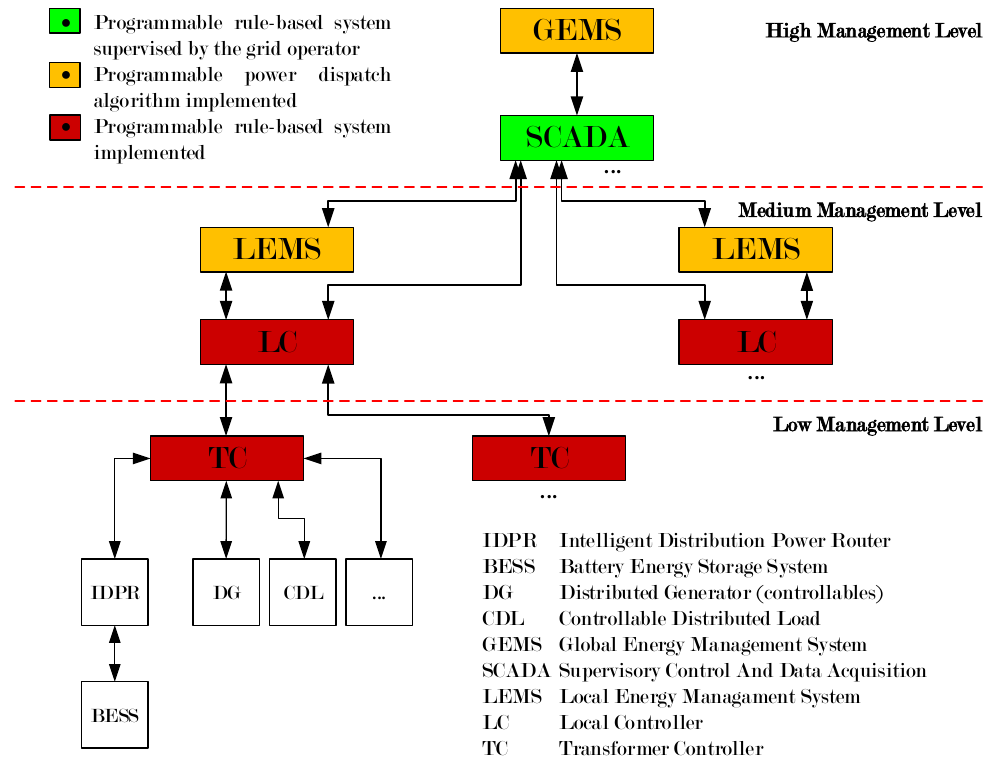
Figure 1. The multi-agent management system for the smart rural